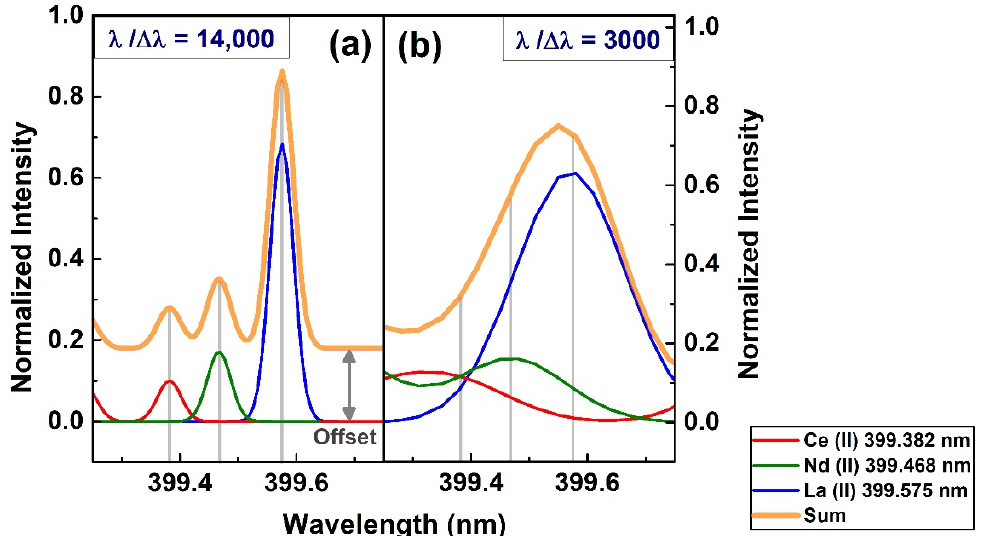
Figure 4. The simulated spectra of Ce (II), Nd (II) and La (II) in our sample with two different spectral resolutions in the spectral range of 399–400 nm. For echelle spectrograph in ( a ) and for the CT spectrometer in ( b ). The spectral parameters were: T = 5500 K and n e = 1 × 10 17 cm − 3 . Likewise, a very strong and distinct Ca (II) 393.366 nm line is shown in Figure 3b. A